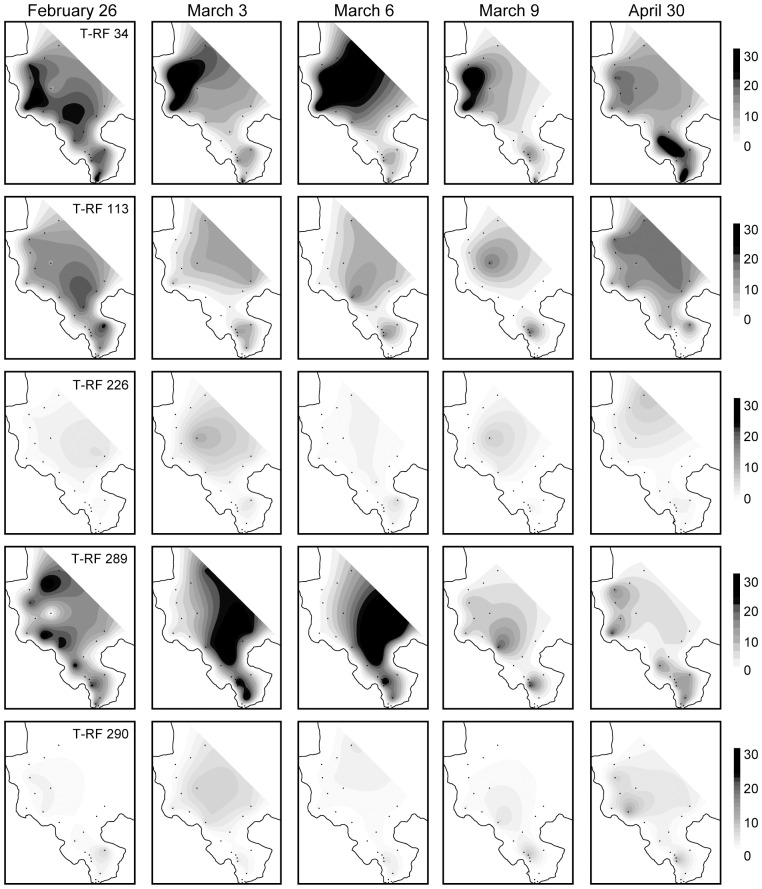
Temporal variation in T-RFs across Kaneohe Bay.Contour plots showing temporal variation in the relative abundance of SSU rRNA gene terminal restriction fragments with the highest contribution to the dissimilarity between storm and non-storm conditions throughout Kaneohe bay immediately prior to (February 26), during (March 3–9), and after (April 30) the March 2006 storm event.